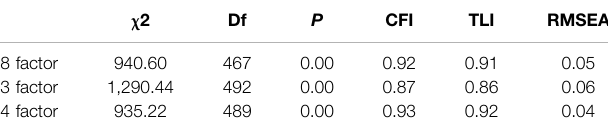
TABLE3| Summaryofmodel fi tindicesfromthecon fi rmatoryfactoranalyseswith fi nal items. χ 2